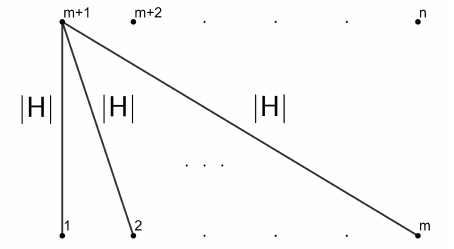
Figure 7. Totally umbilical submanifold with mean curvature vector field H